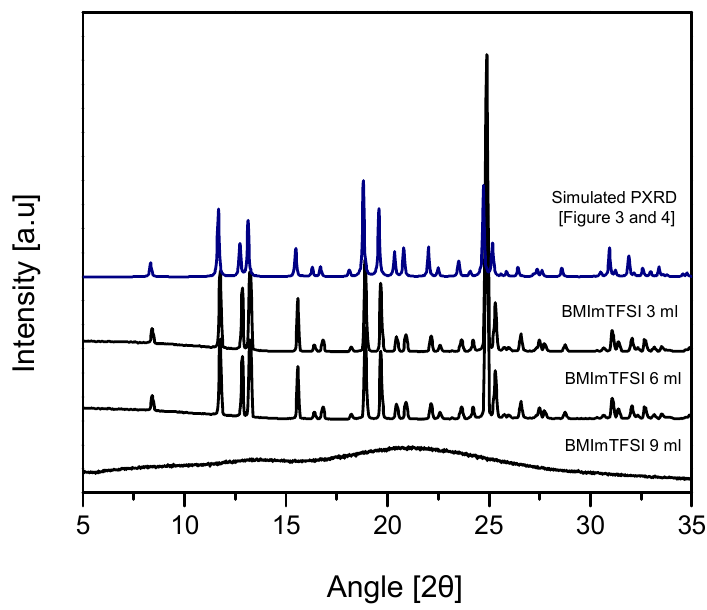
Figure 8. PXRD patterns of sucrose crystals precipitated from the MeOH extraction solution of A. gigas at a constant solvent volume of 3 mL under BMImTFSI anti-solvent composition change conditions.